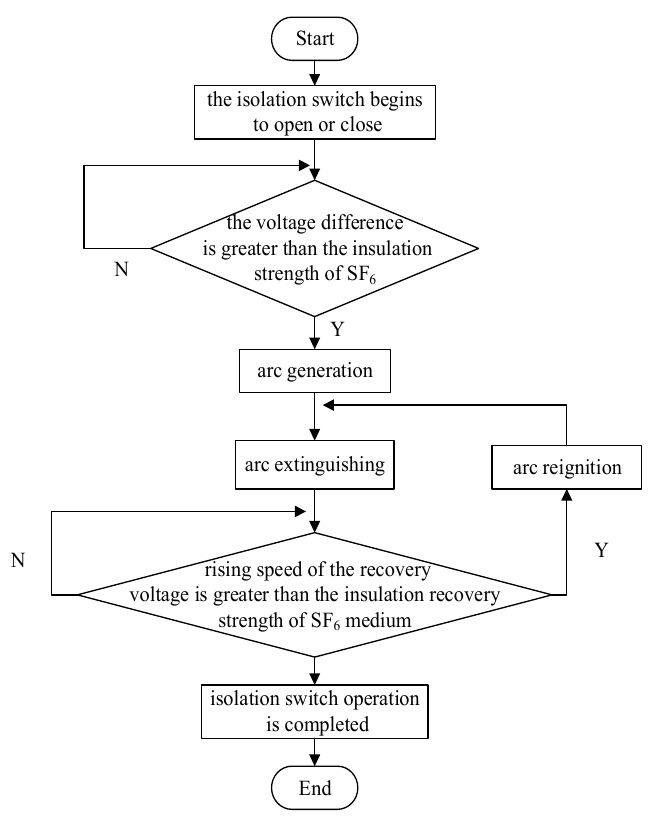
Figure 2. Arcing and reignition process in isolation switch operation. The voltage wave generated in this process continuously reflects, refracts in the GIS substation line, and is superimposed to form VFTO. The basic oscillation frequency of VFTO is determined by the parameters of capacitance and inductance of the line, and